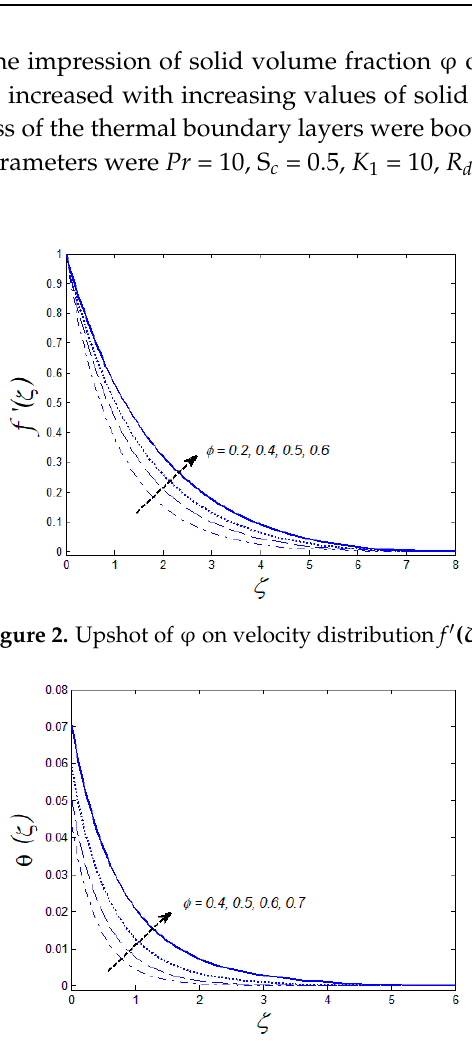
Figure 3. Upshot of φ on temperature field θ ( ζ ) .